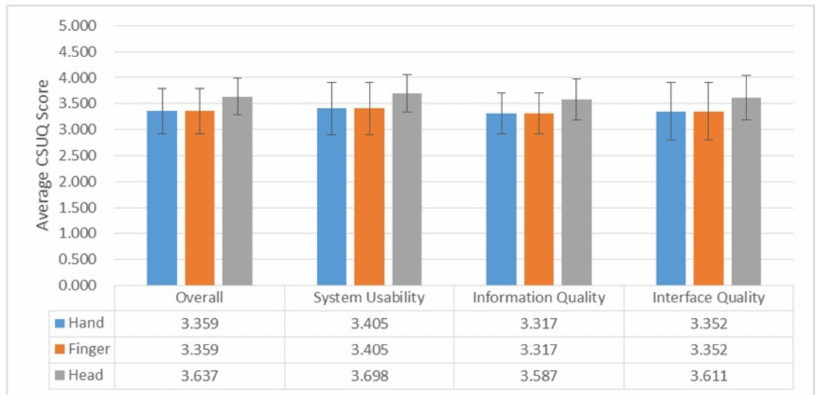
Figure 10. Average of the computer system usability questionnaire (CSUQ) scores for each interaction ( +/ - standard deviation of the average).